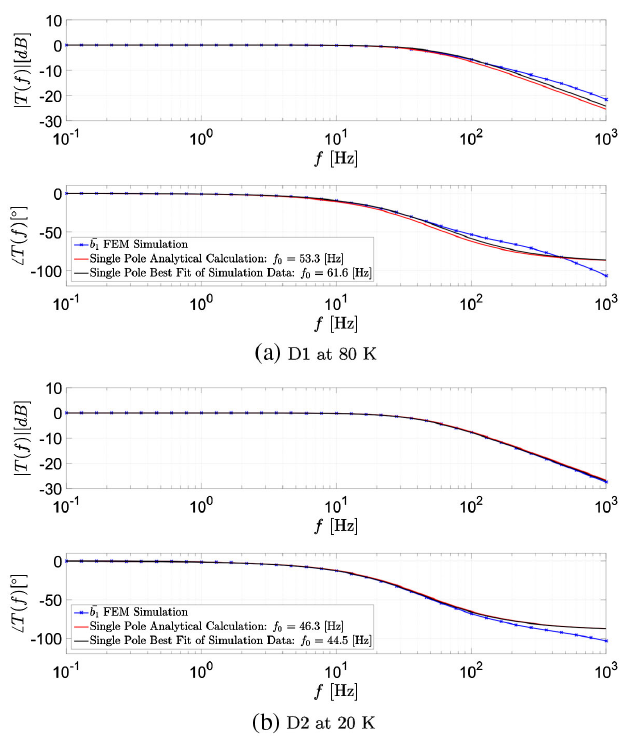
FIG. 12. Frequency response of the shielding effect inside the HL-LHC separation-recombination dipoles.